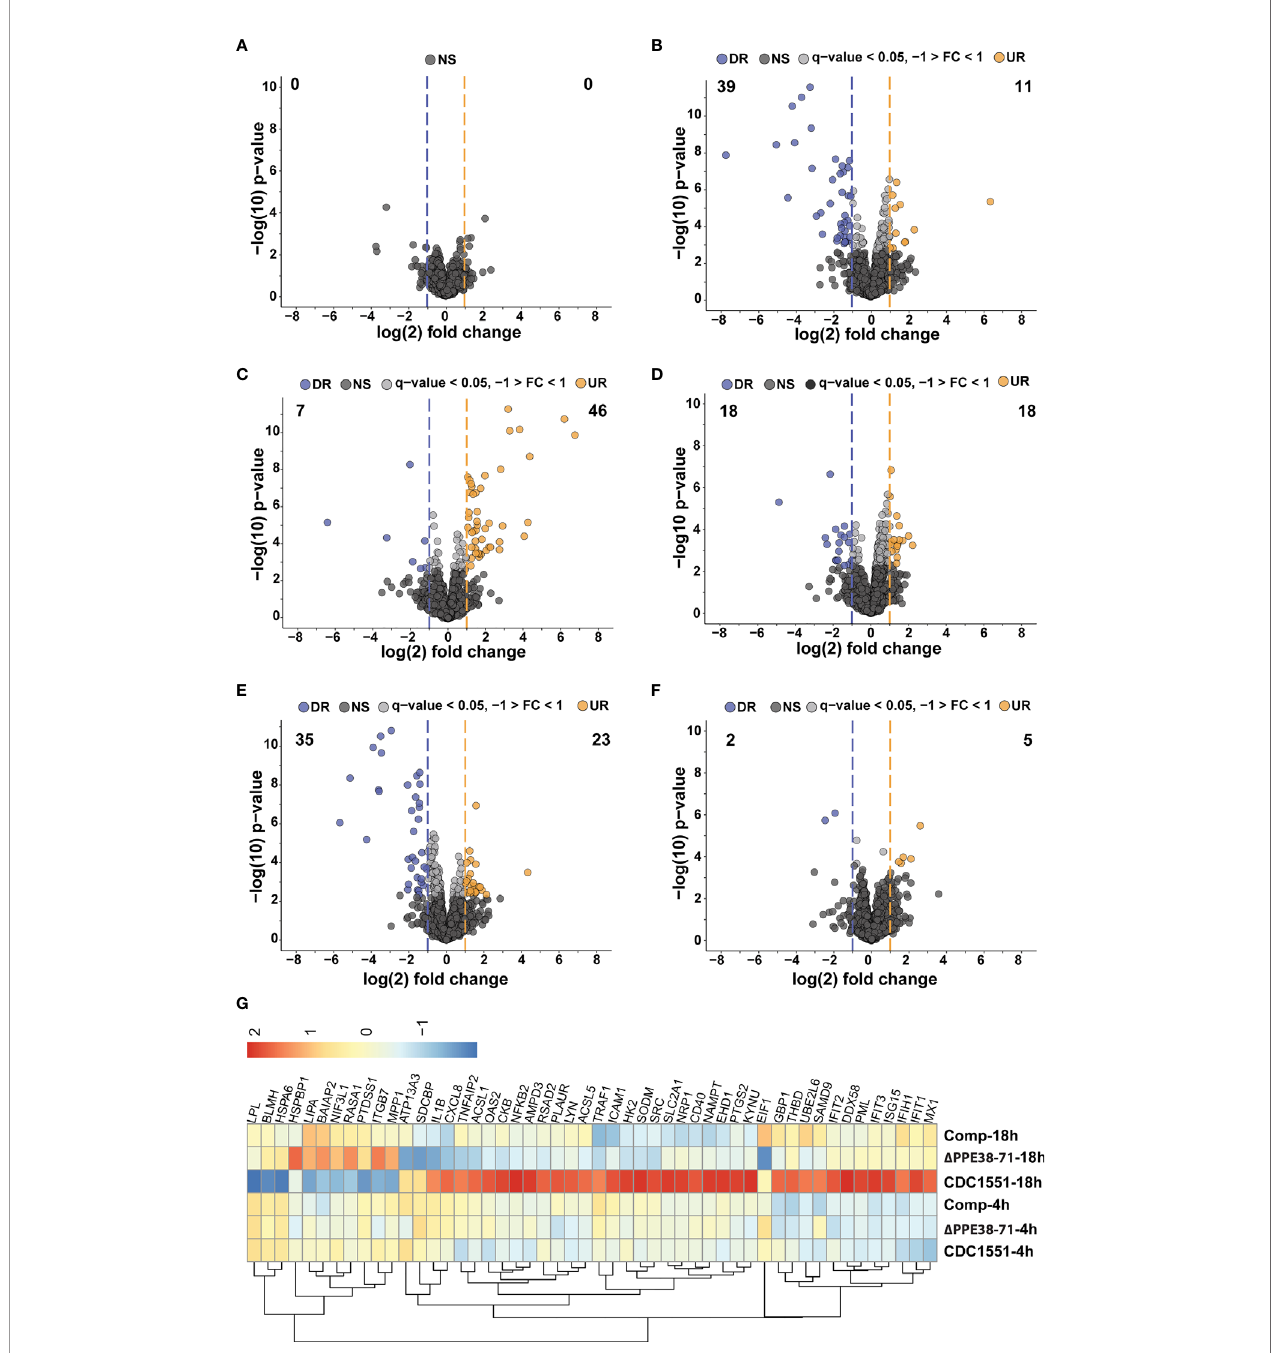
FIGURE 2 | Label-free proteomic analysis reveals altered in fl ammatory responses in M. tuberculosis -infected macrophages. Volcano plots representing differential protein abundance in macrophages infected with M. tuberculosis CDC1551 compared to infection with D ppe38-71 at (A) 4 hours post-infection, (B) 18 hours post- infection, (C) infection with M. tuberculosis CDC1551 at 18 hours compared to 4 hours and (D) infection with D ppe38-71 at 18 hours compared to 4 hours post infections. Signi fi cance cut-offs were set at a q-value less than 0.05 and a log2 fold change greater than 1. Numbers indicate the amount of signi fi cantly regulated proteins. (E) Volcano plot representing regulated proteins of THP-1 macrophage-like cells infected with the complemented strain compared to M. tuberculosis CDC1551 at 18 hours post-infection. Signi fi cance cut-offs were set at a q-value less than 0.05 and a log2 fold change greater than 1. (F) Volcano plot representing proteins of THP-1 macrophage-like cells infected with the complemented strain at 18 hours compared to 4 hours post infection. Signi fi cance cut-offs were set at a q-value less than 0.05 and a log2 fold change greater than 1. (G) Heat map of the main regulated proteins between the groups, displaying the log 2 fold changes between THP-1 macrophage-like cells infected with M. tuberculosis CDC1551, D ppe38-71 and the complemented strain at 18 hours post-infection. LFQ intensities were Z-scored and are from three independent biological